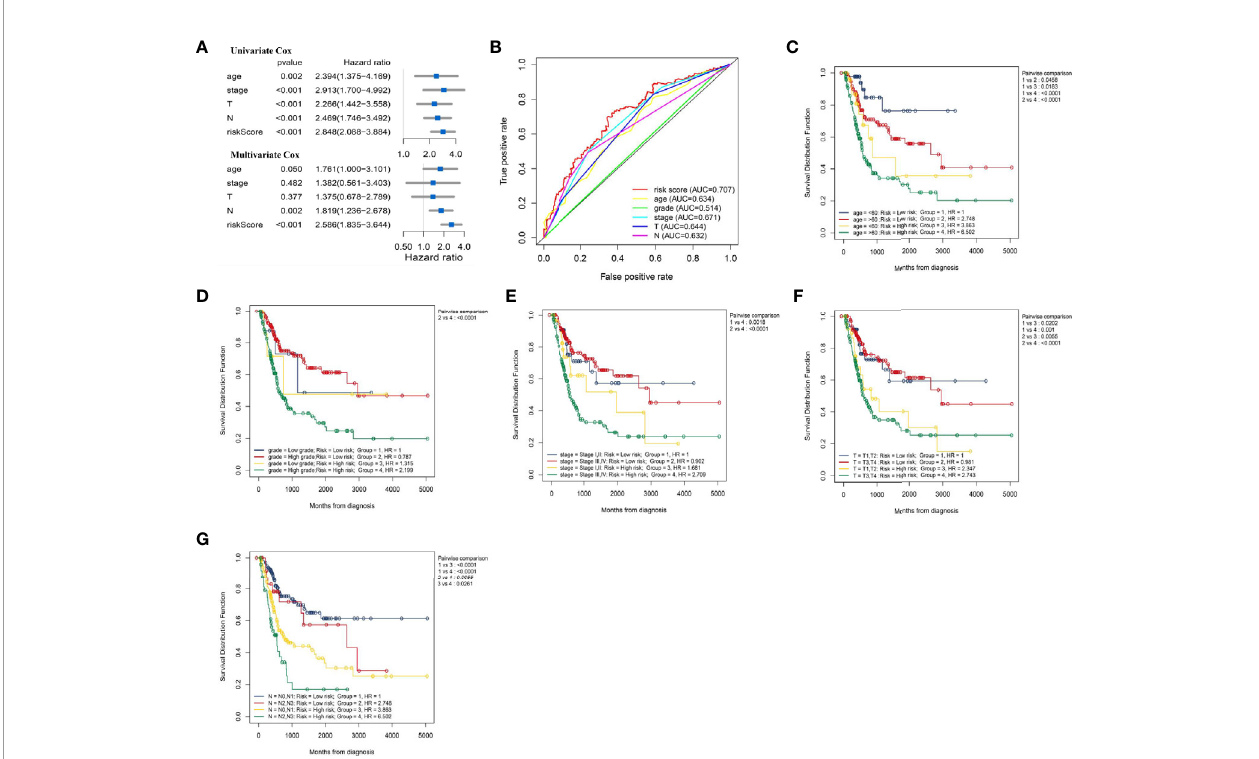
FIGURE 5 | Evaluate whether lncRNA signature is an independent prognostic factor and relationship between risk score and clinical characteristics. (A) Forest plot of univariate and multivariate Cox regression results of lncRNA signature and clinical characteristics. (B) ROC curve of clinical characteristics and signature risk score for 3-year OS. Two factors Kaplan – Meier curves of overall survival for patients in TCGA cohort strati fi ed by IRL- signature, age (C) , grade (D) , WHO stage (E) , AJCC-T stage (F) , and AJCC-N stage (G) . ROC, receiver operating characteristic; WHO, World Health Organization; AJCC, American Joint Committee on Cancer; AUC, area under the